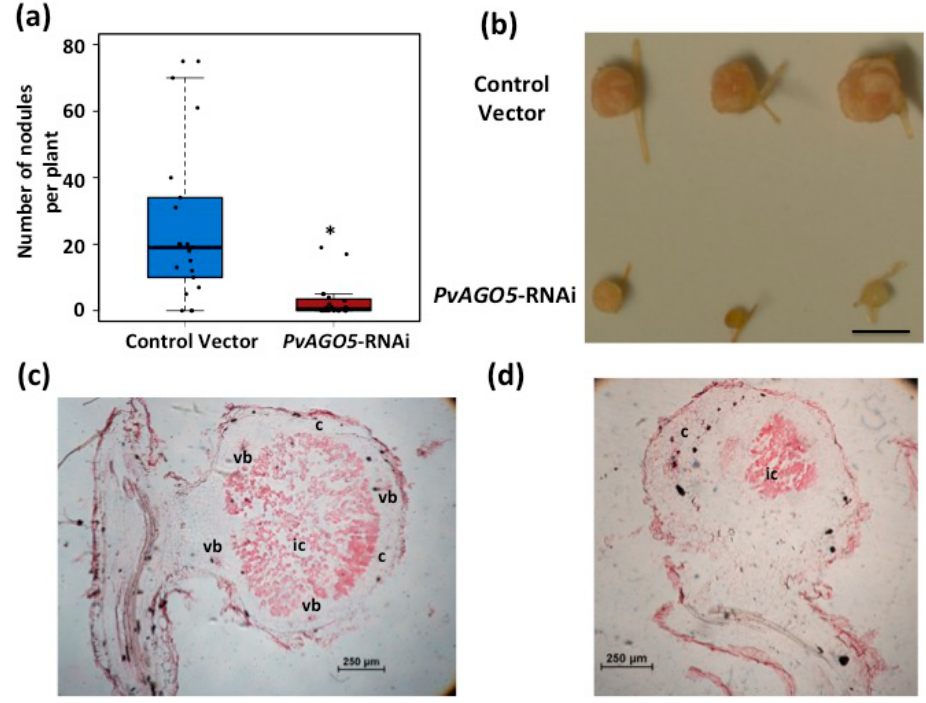
Figure 4. PvAGO5 -silenced roots develop less, small and white nodules in common bean. ( a ) Nodulation assay on control- and PvAGO5 -silenced common bean transgenic roots. Data shown was obtained from 30 independent biological replicates. One-way ANOVA followed by a Tukey HSD test was performed. Asterisk indicates a significant difference ( p -value < 0.01); ( b ) Nodules observed in control- and PvAGO5 -silenced common bean transgenic roots. ( c , d ) Safranine-stained sections of R. tropici -inoculated nodules showing the morphology and organization of representative samples collected from transgenic control ( c ) and PvAGO5 -RNAi ( d ) roots. c: Cortex; ic: infected cells; vb: vascular bundle.